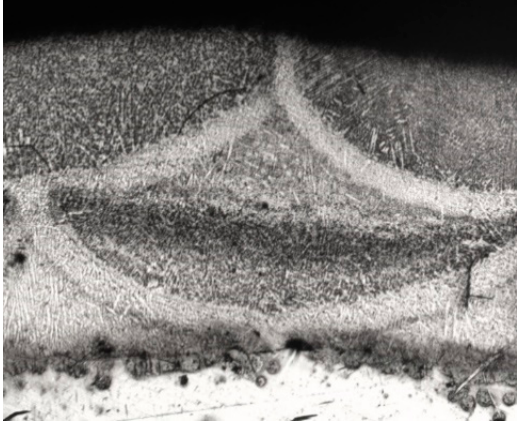
Figure 17. The cross section of a double composite layer (50 ×).